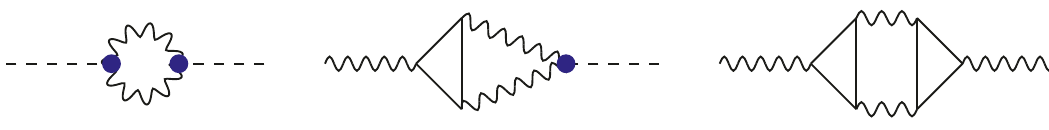
Figure 1 . Kinetic term for the (cid:12)eld a and the mass term for the Z 0 gauge boson induced by the radiative corrections in the U(1) anomalous theory. Note that each blob corresponds to the couplings (2.2) and is therefore naturally of the size of the fermionic triangle